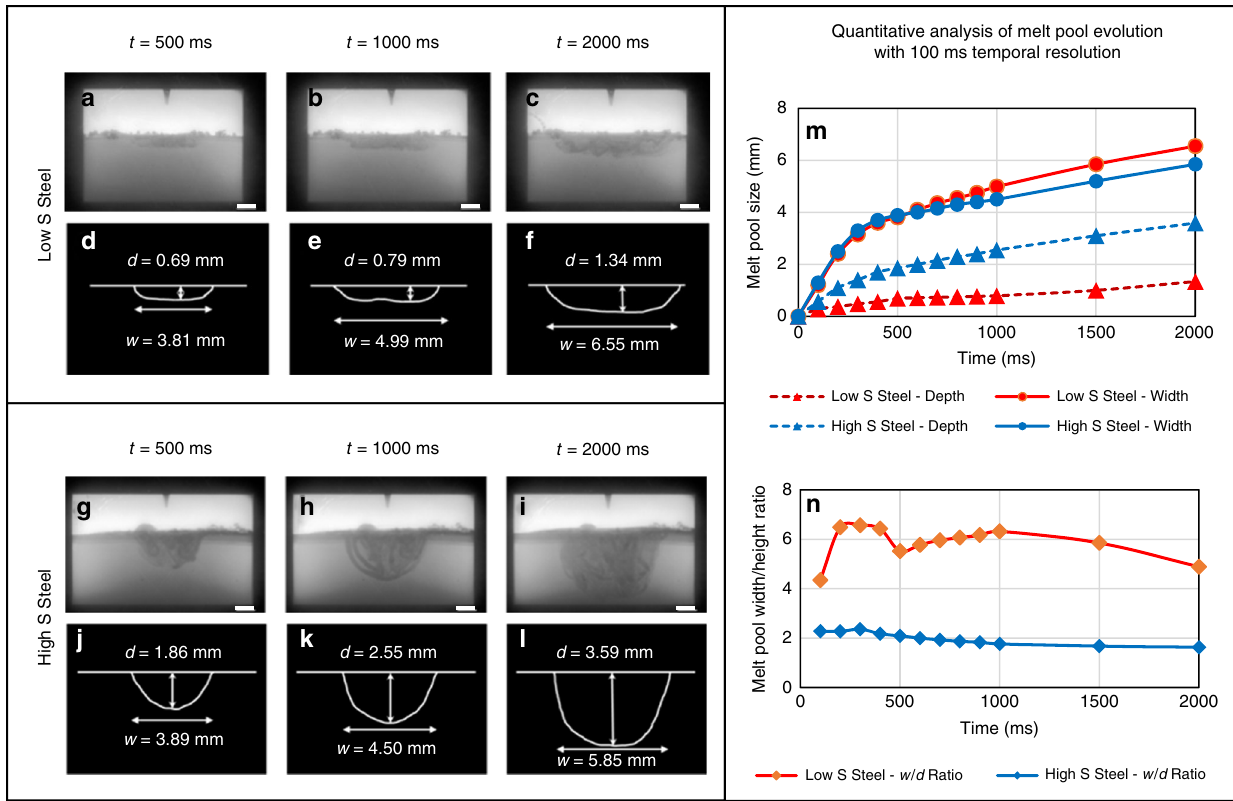
Fig. 2 Quantitative analysis of time dependent evolution of melt pool morphology. a – l Synchrotron X-ray radiographs of the evolving melt pool at three- time instances in situ. The corresponding measured geometries are below the respective radiographs. The melt pools are created using the same melting parameters and sample dimensions. Panels a – f are from a low S steel melt pool, while g – l are from a high S steel melt pool. Melt pool size evolution is quanti fi ed with 100 ms temporal resolution in m and n . It is evident that the high S melt pool favours downward growth to penetrate a depth of 3.59 mm, over 150% deeper than the low S melt pool. All scale bars = 1